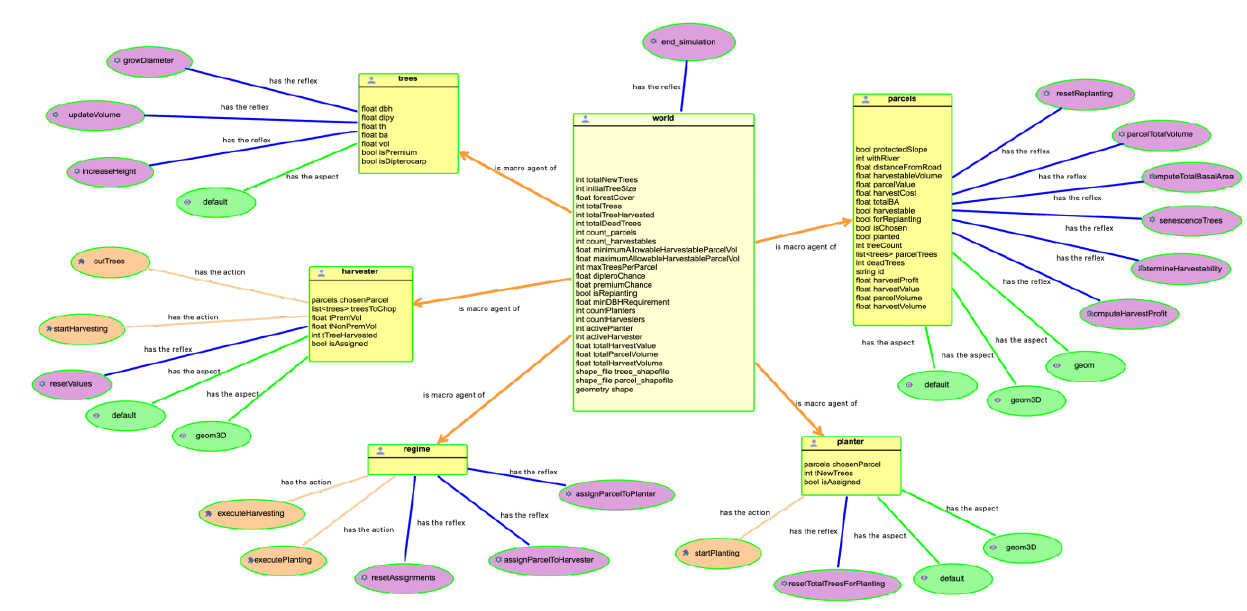
Figure 5. Conceptualization of the GAMA Forest Model.